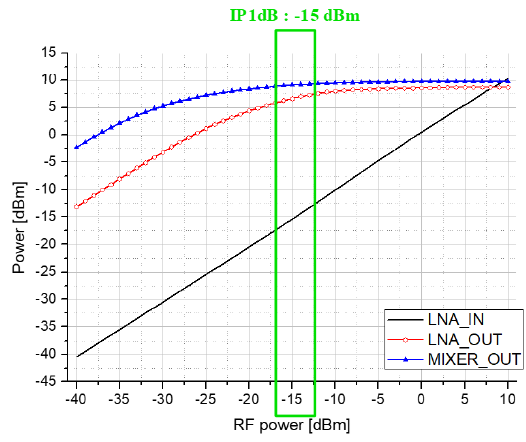
Figure 20. Front-end P1dB simulation